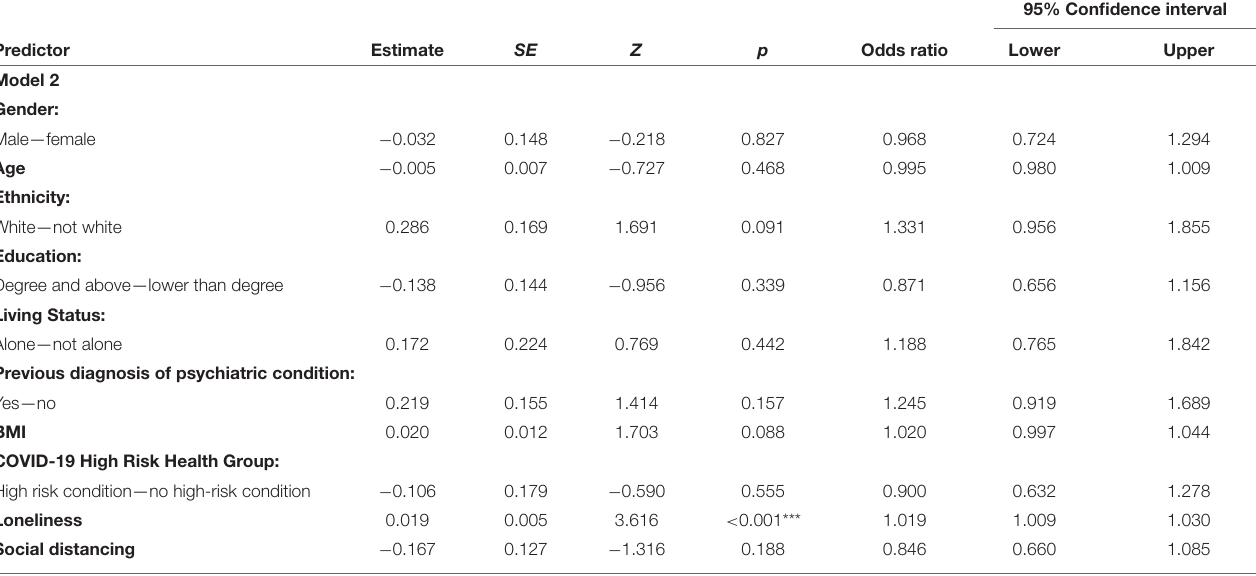
TABLE 3 | Results of ordinal logistic regression on no. health-related behaviors